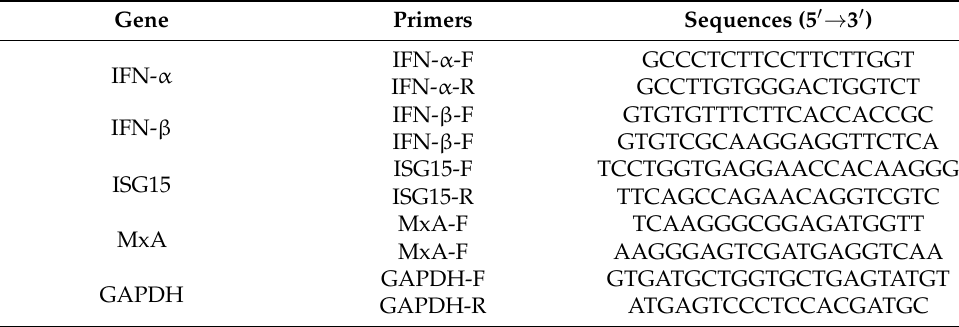
Table A1. Primers used for RT-qPCR